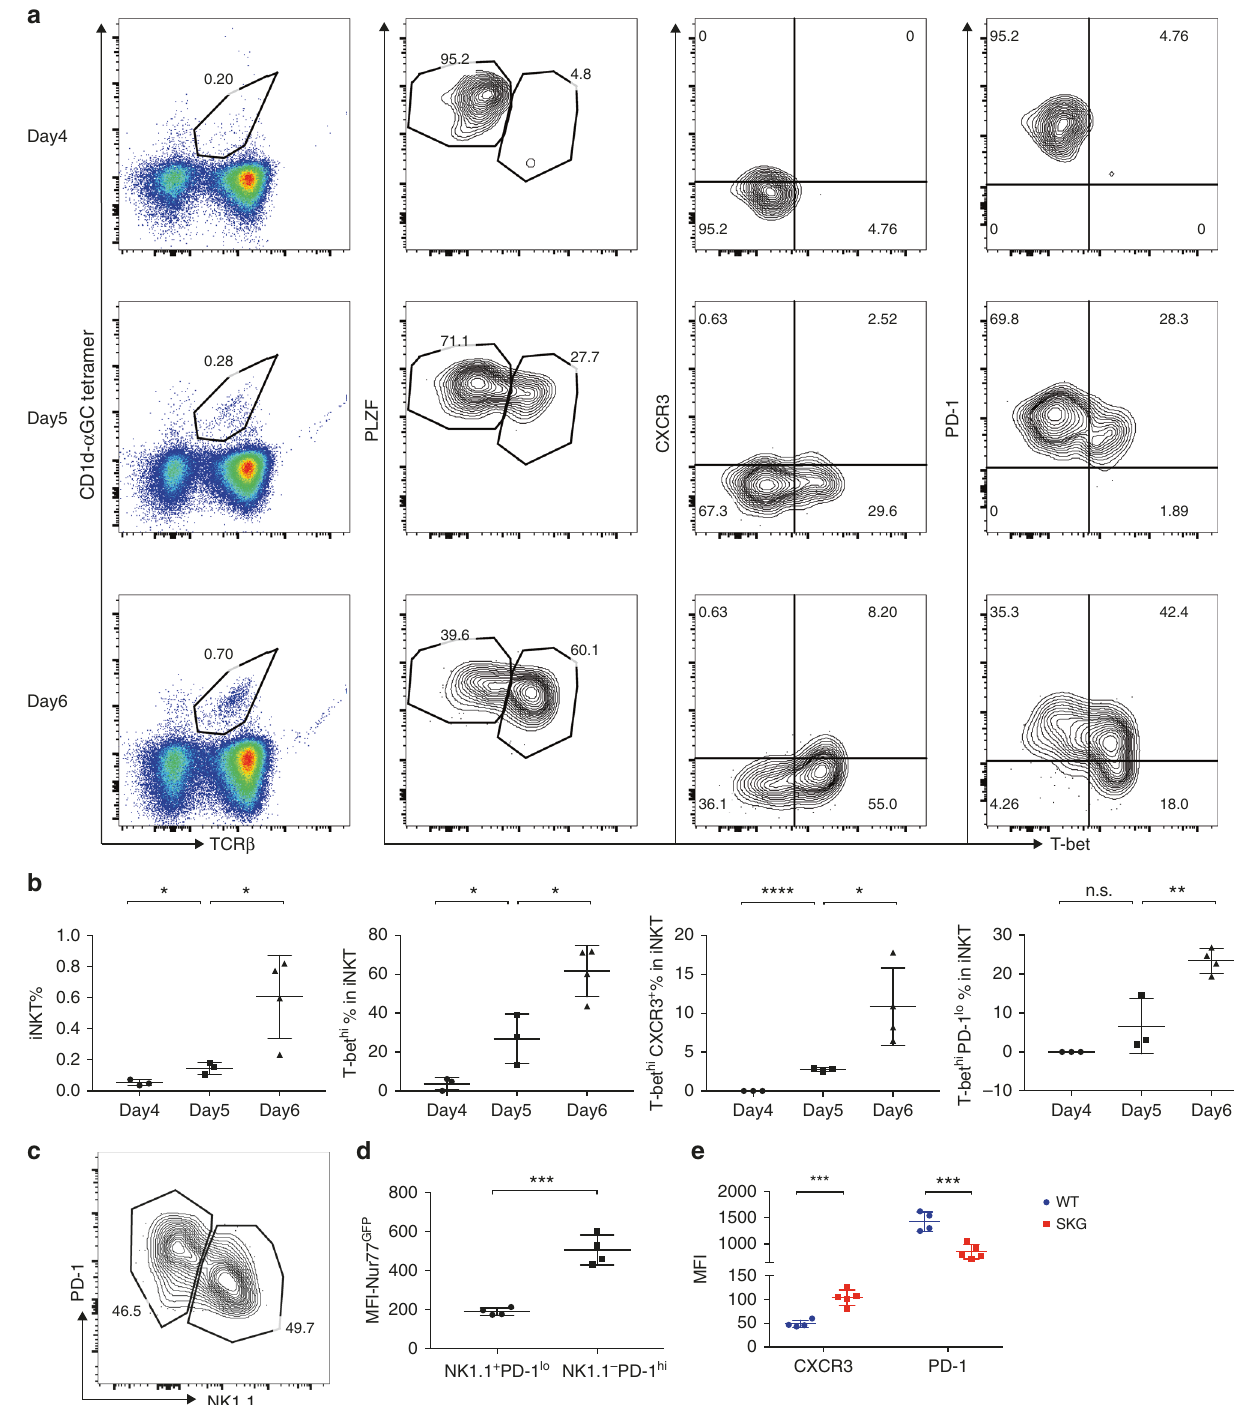
Fig. 2 The development of iNKT cell subsets in thymic organ culture. a , b Thymic lobes from E18.5 — day 0 BALB/c embryos were cultured in vitro and examined on days 4, 5, and 6. Percentages of total iNKT cells (TCR β int , α GC tetramer + ) in live cells are shown (left column). Expression of transcription factors T-bet and PLZF (second column), surface markers CXCR3 and PD-1 (third and fourth columns) in total iNKT cells are shown. b Compiled data of the experiments. c Thymic lobes from day 0 Nur77 gfp mice were cultured in vitro as in ( a ). d Total iNKT cells were separated into NK1.1 + PD-1 lo (NKT1-like) and NK1.1 − PD-1 hi (NKT2-like) populations and MFI of GFP from the two populations were plotted. e Thymic lobes from day 0 SKG and WT control mice were cultured in vitro as in ( a ), and expression levels of CXCR3 and PD-1 were compared. Data are representative of three independent experiments. Graphs represent mean ± SD with symbols representing individual mice. * p < 0.05; ** p < 0.01; *** p < 0.001; **** p < 0.0001; n.s. not signi fi cant (unpaired two-tailed Student ’ s t